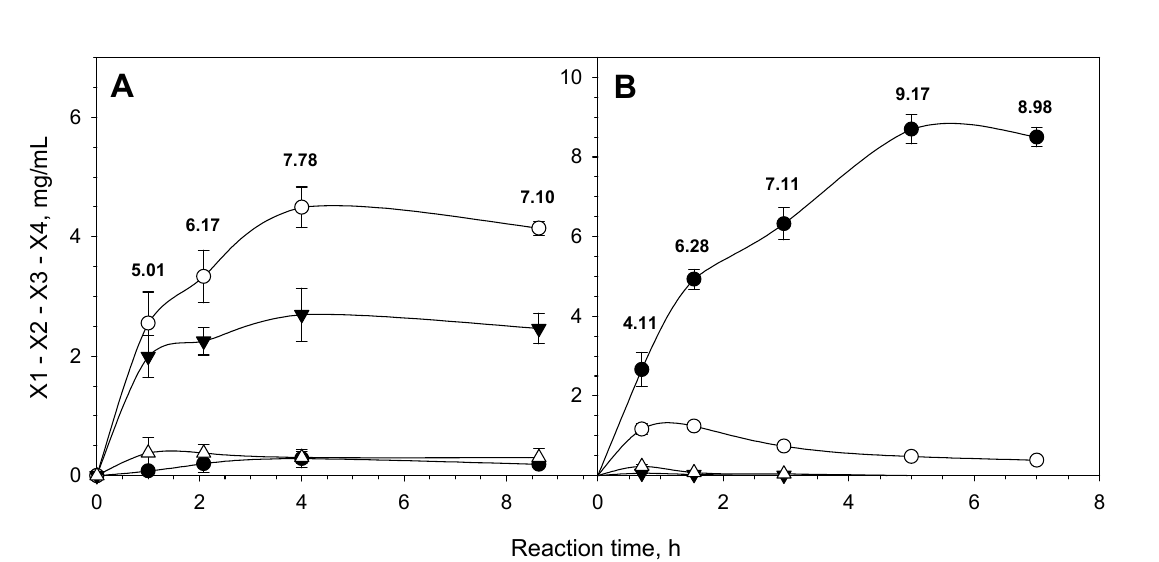
Figure 5. Hydrolysis of beechwood xylan (initial concentration of 25 g/L) by only the xylanase PvXyn11A (25 nkat/mL— ( A )) and a mixture of PvXyn11A and PvXyd3A (25 nkat/m–2.5 nkat/mL—( B )) at pH 4 and 50 °C. ● , xylose (X1); ○ , xylobiose (X2); ▼ , xylotriose (X3); ∆ , xylotetraose (X4). Numbers at each time point indicate the sum of X1 to X4 (mg/mL). Data are the means of triplicate reactions with standard deviations.